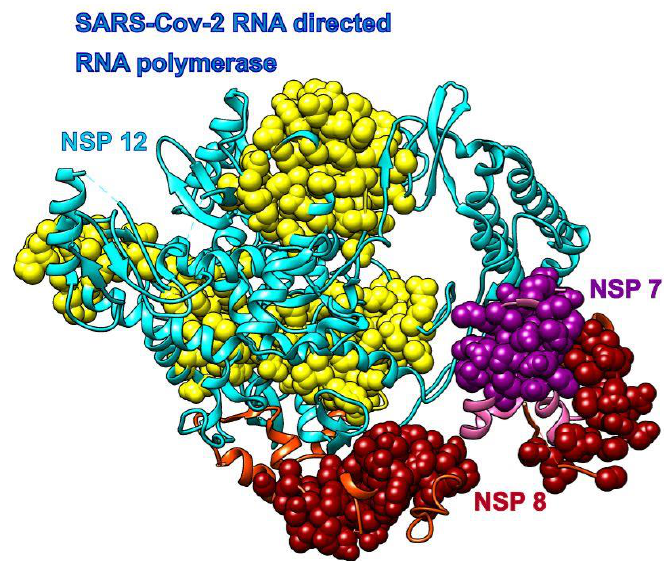
Figure 5. COVID-19 RNA directed RNA polymerase with cofactors NSP7 and NSP8 (pdb id 6m71). The NSP 12 chain is cyan, and its SAGNM predictions are yellow. The NSP 7 chain is pink and its SAGNM predictions are purple. The NSP 8 chain is orange and SAGNM predictions are dark red. The dashed lines represent segments missing from the coordinates